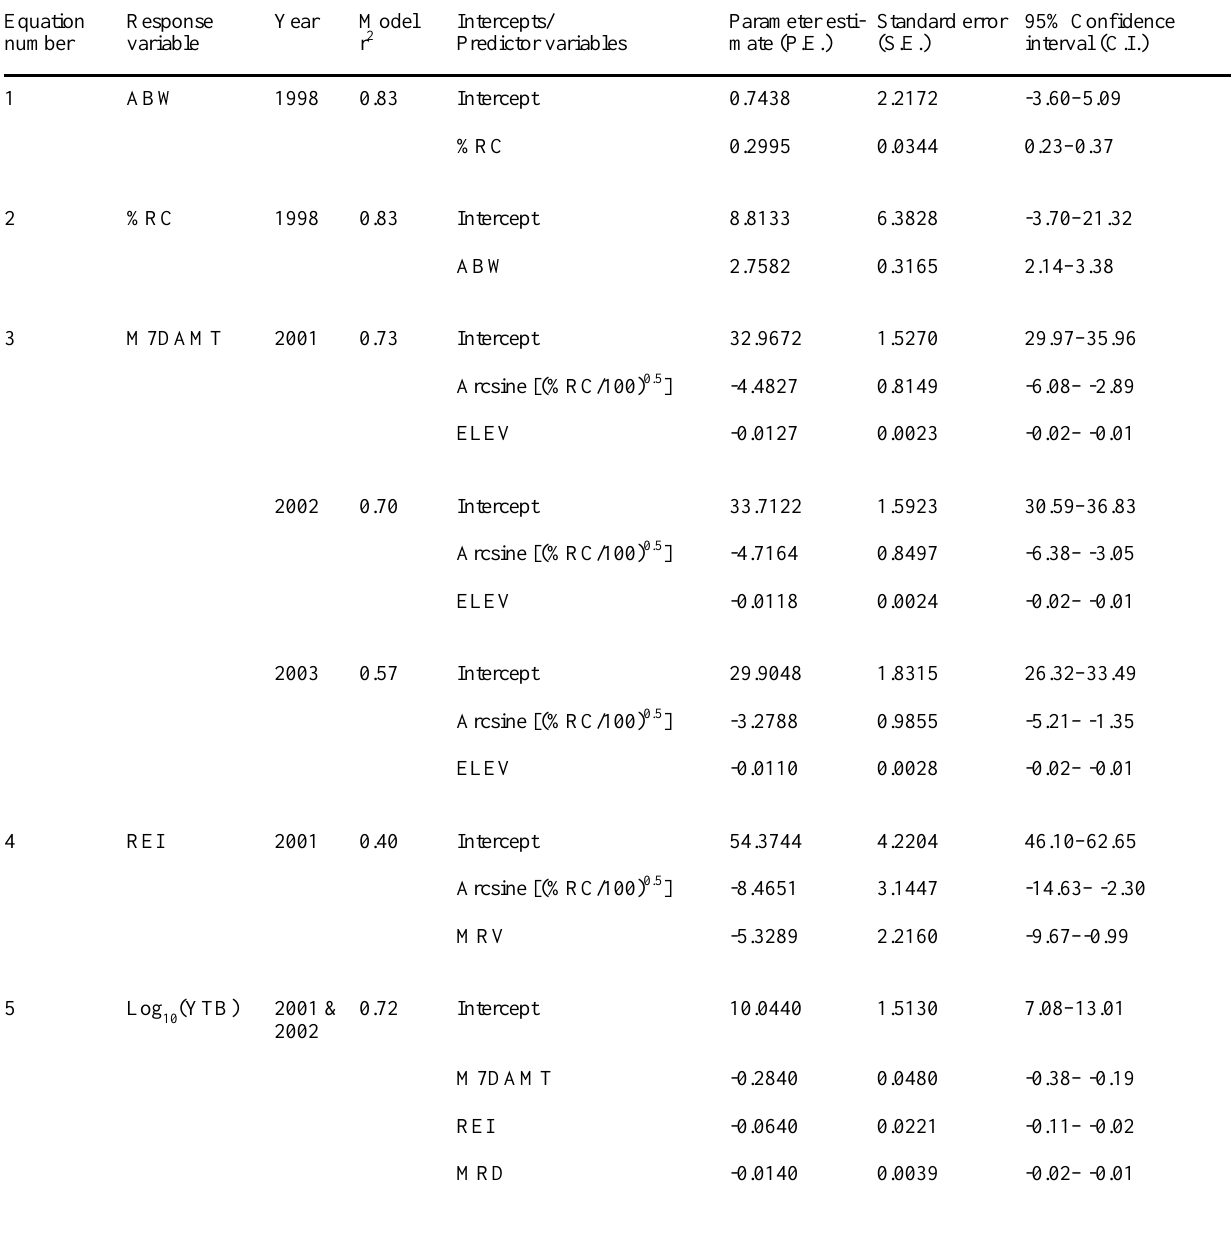
Table 5. Parameter estimates for Eqs. 1–5, which quantify the relationships between average forested widths of riparian buffers, percent riparian forest cover, instream habitat, and young trout populations in north Georgia. All models and parameter estimates are significant at a = 0.05. The 95% confidence interval (C.I.) is calculated as Parameter Estimate ± 1.96 · S.E. (Sokal and Rohfl